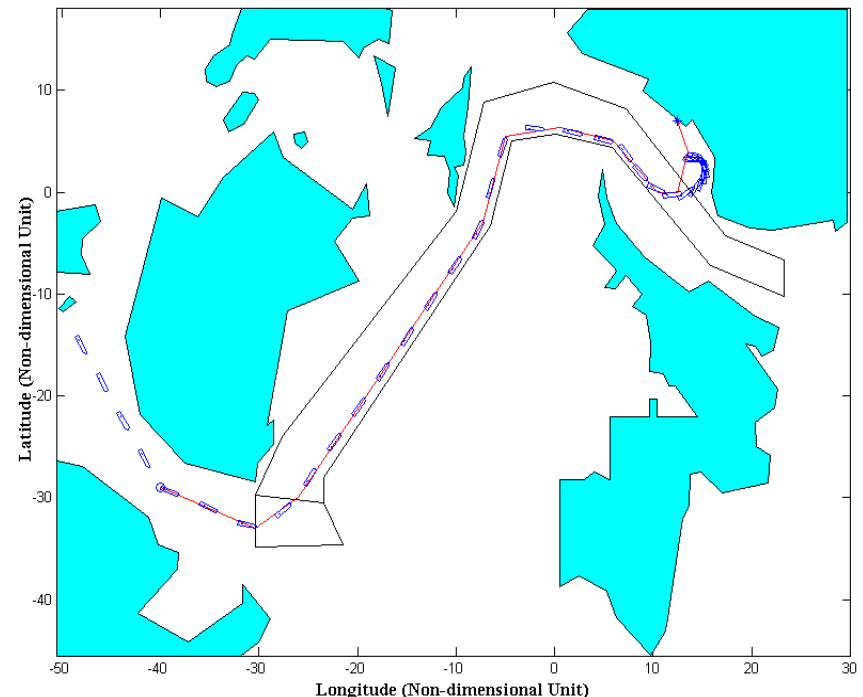
Figure 13. The track of ship controlled by an automatic navigation system without the heading stabilizing controller.